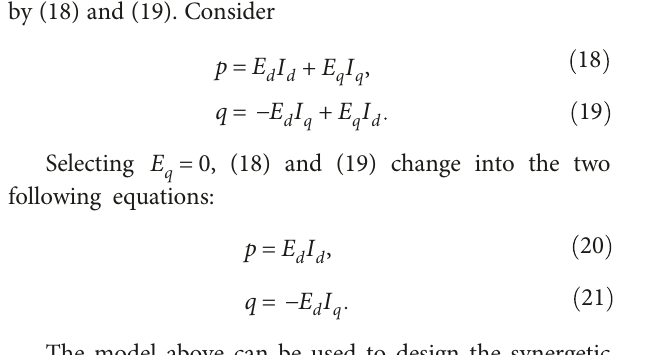
Figure 4: Principle of voltage support in the event of grid faults.